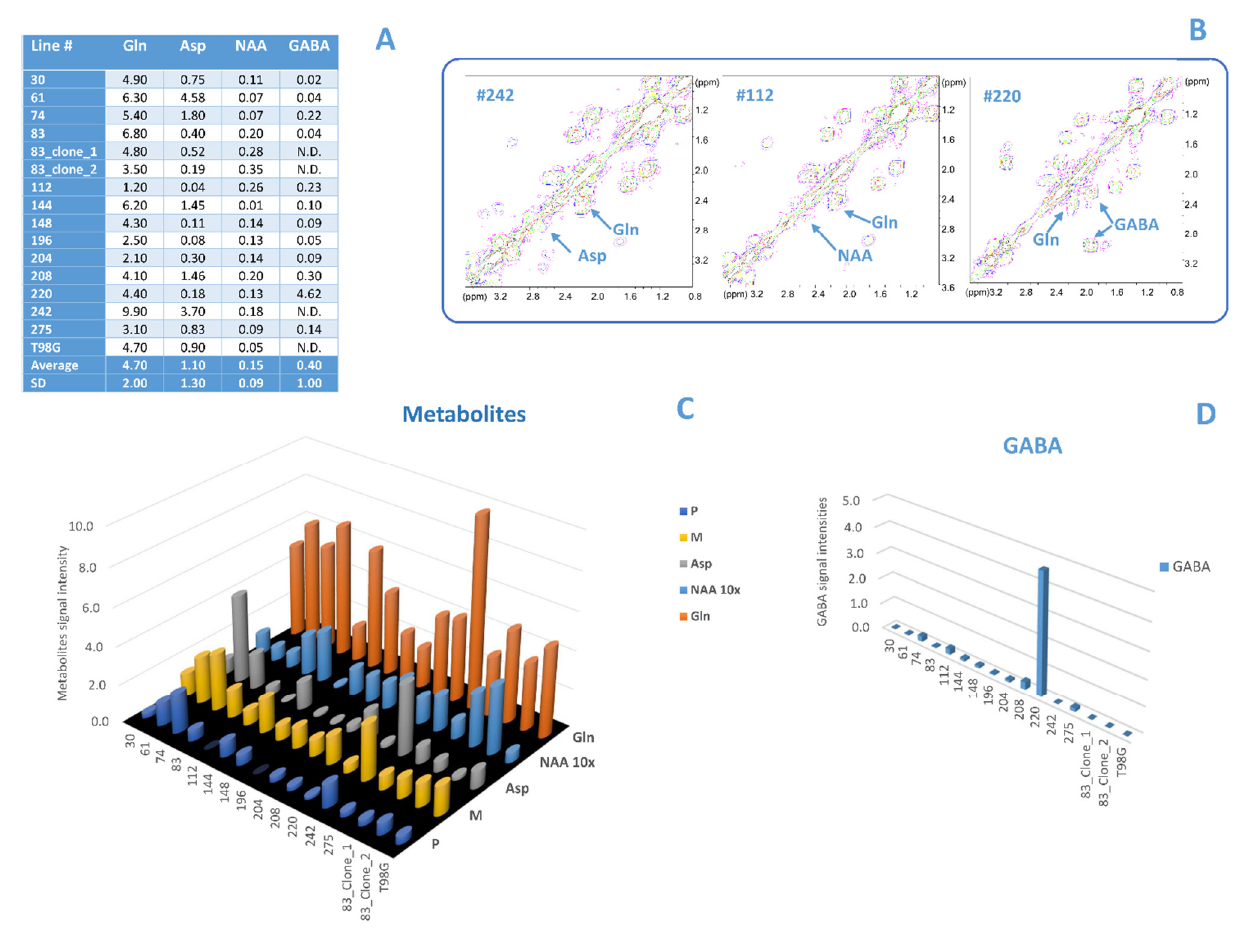
Figure 4. ( A ) Average values and standard deviations of all analyzed no lipid metabolites (Gln, Asp, NAA, GABA) signal intensities, calculated on at least three independent experiments. ( B ) 2D COSY spectra of lines #242, #112, and #220, respectively; regions of interest are shown: Gln cross peak at 2.44–2.13 ppm, Asp cross peak at 2.80–2.68 ppm, NAA cross peak at 2.67–2.48 ppm, and GABA cross peak at 2.30–1.90 ppm. ( C , D ) Bar graphs reporting cross-peak intensities of Gln, Asp, NAA, M, and P ( C ), and GABA ( D ) for all analyzed MES cell lines, for the subclones and T98G. The intensity of the NAA cross peak is reported as 10×. N.D. stands for undetectable.